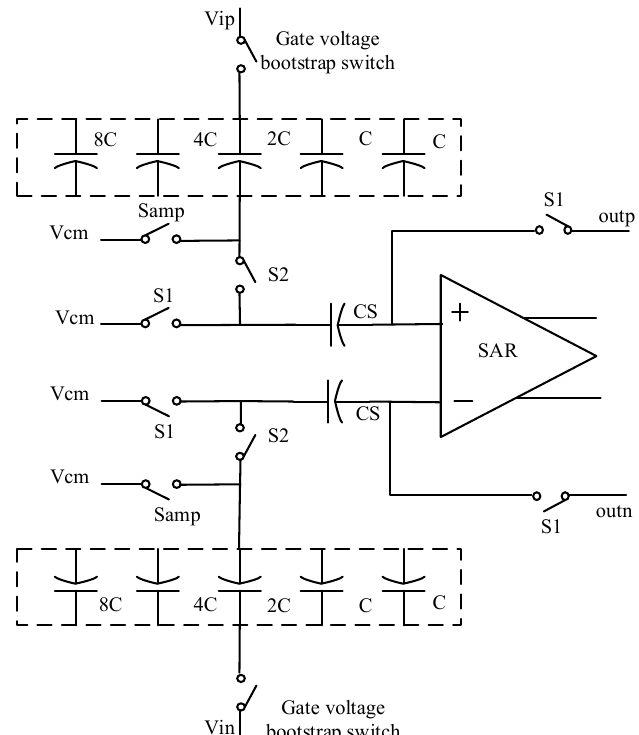
Figure 4. Quantizer sampling circuit.